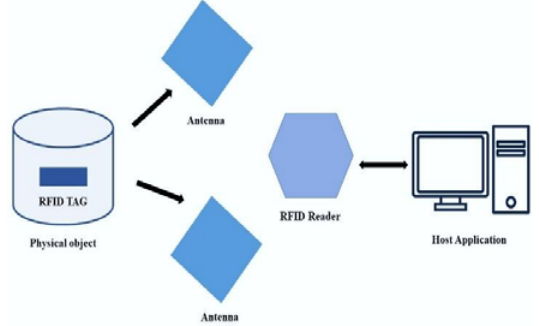
Fig.1. RFID System